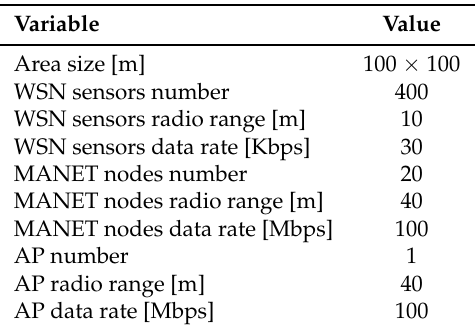
Table 1. Scenario 1 simulation variables